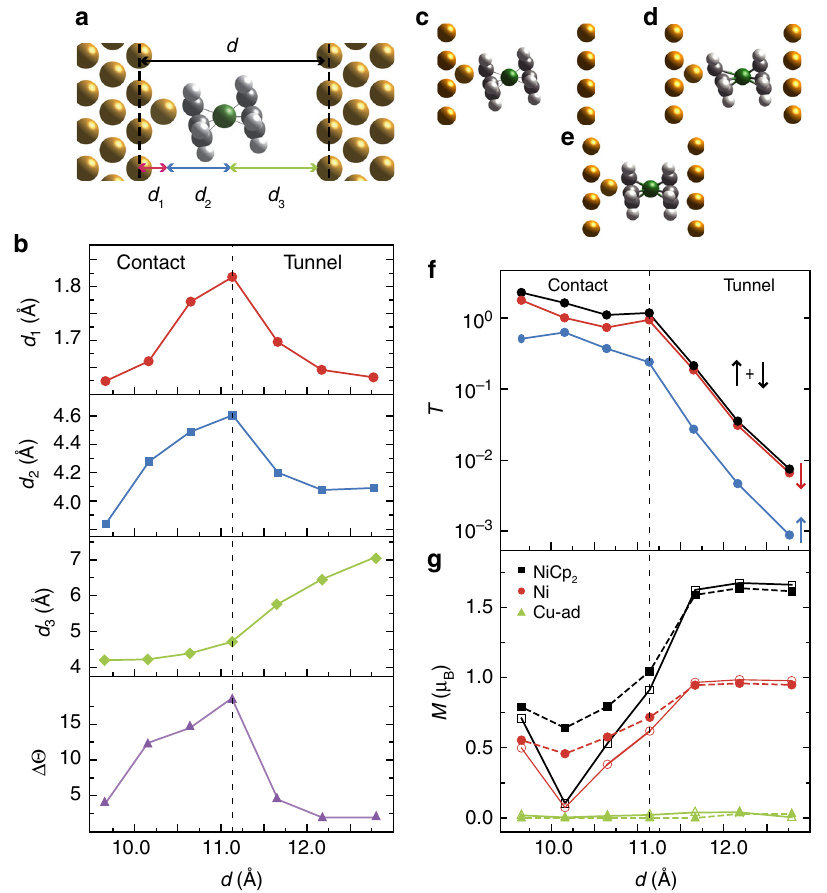
Fig. 3 Structural and magnetization analysis of the molecular junction. a Structure of the calculated molecular junction, including the main relevant distance parameters. b The panels show how the structural parameters d 1 , d 2 , d 3 , ΔΘ change as a function of d . The structure of the molecular junction for: c the tunneling regime ( d = 12.17 Å), d the transition between the tunneling and the contact regimes ( d = 11.14 Å), and e the contact regime ( d = 9.66 Å). f Total transmission (black line) and the transmission per spin channel (red and blue lines) at the Fermi level for the explored con fi gurations. g Magnetization of: Nc (black), Ni (red), Cu atom (green) as a function of d . Full symbols correspond to SIESTA (Mulliken) results and open symbols to VASP (Bader)